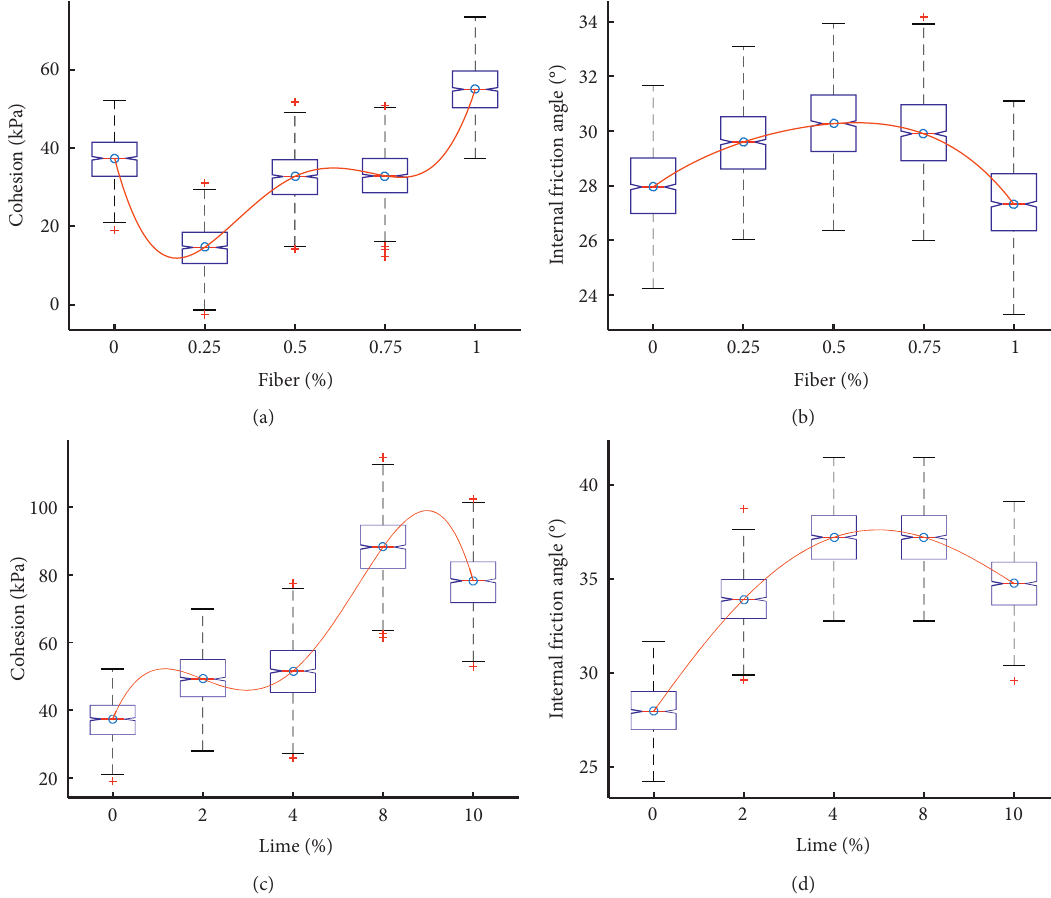
Figure 8: The change trend of the confidence interval of c and φ of the modified iron tailings with the one freeze and thaw cycle: (a) the confidence interval of c varies with the fiber content, (b) the confidence interval of φ varies with the fiber content, (c) the confidence interval of c varies with the lime content, and (d) the confidence interval of φ varies with the lime